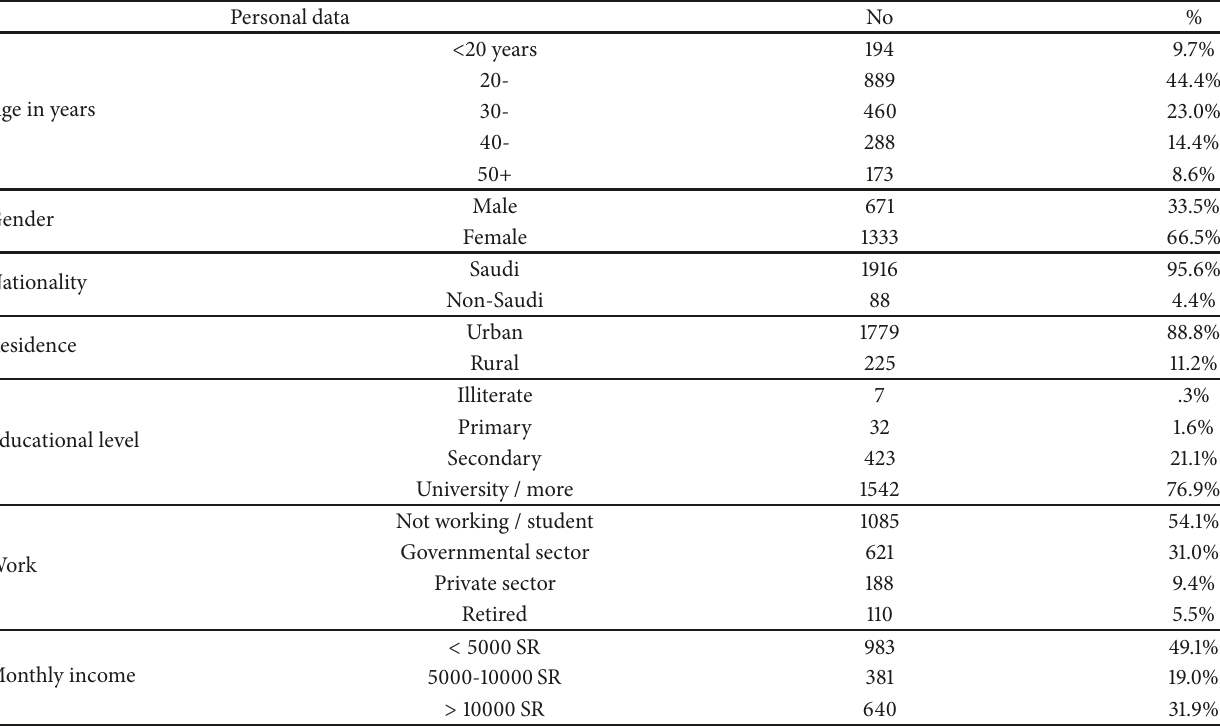
Table 1: Personal data of general population shared in preference and values of stroke intervention, Kingdom of Saudi Arabia, 2018 .